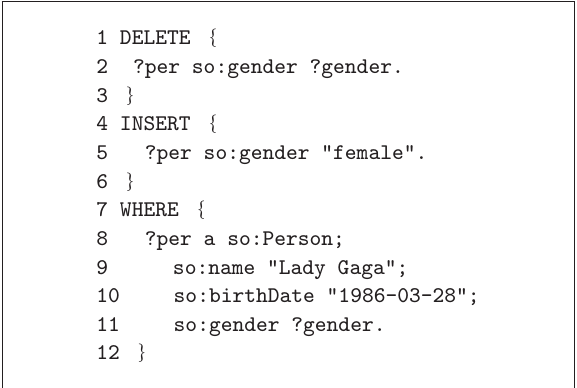
DATA operations before execution. We exploit this fact in Algorithm 2 which transforms DELETE/INSERT